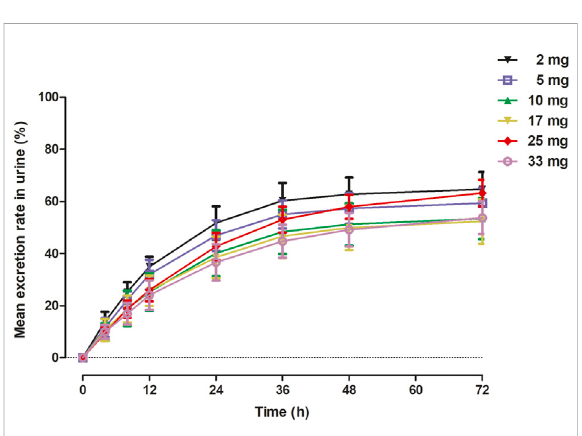
FIGURE 3 Mean excretion rate (%) versus time in urine in 72 h following a single dose of